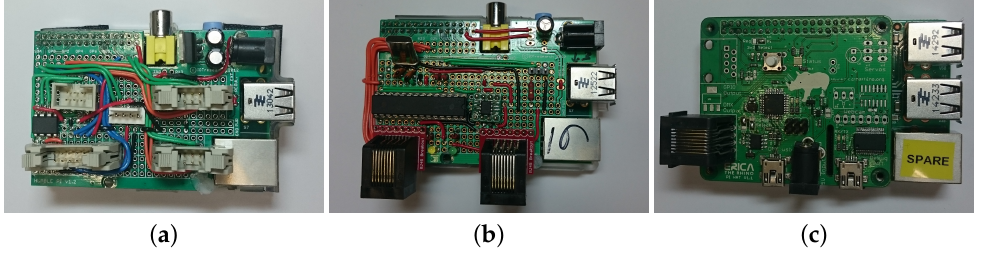
Figure 6. ( a ) an original electronics interface board; ( b ) second generation hardware interface; ( c ) current hardware interface